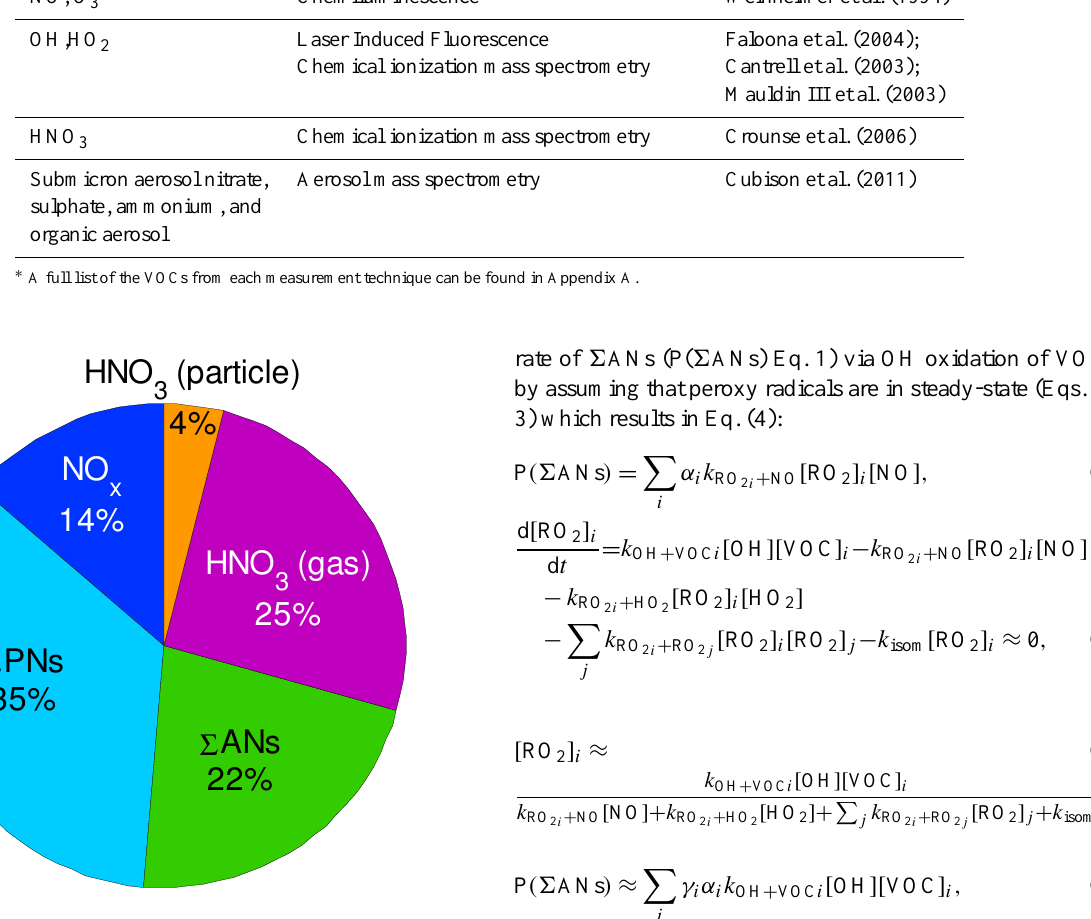
Fig. 2. NO y composition in the boundary layer over the remote bo- real forest for background conditions (see text). HNO 3 (particle) refers to submicron particulate NO − as measured by the AMS and 3 may include a contribution from particulate 6 ANs (see